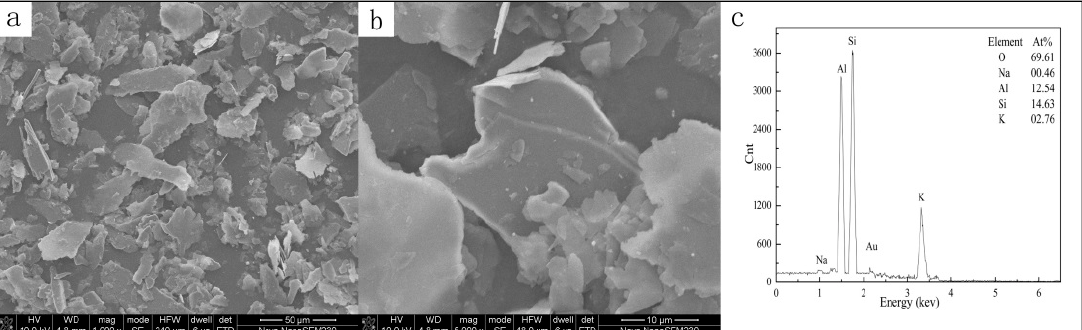
Figure 5. SEM-EDS analysis of raw sericite: ( a ) Magnification is 1000 times and scale bar is 50 μ m; ( b ) Magnification is 8000 times and scale bar is 5 μ m; ( c ) EDS.